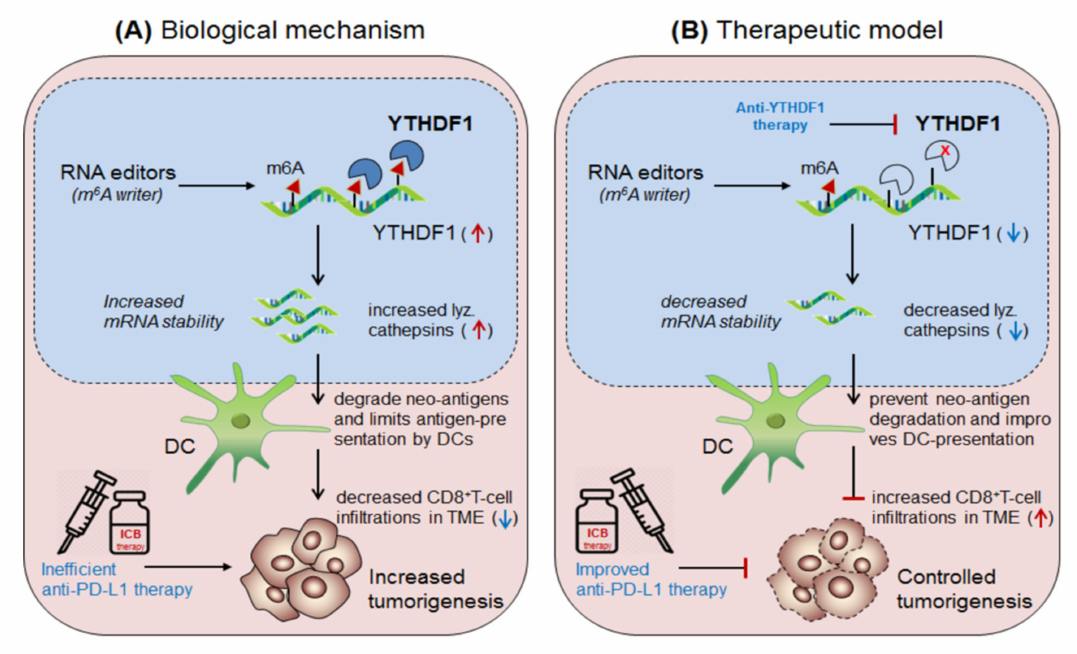
Figure 7. Therapeutic model targeting intracellular checkpoint ‘YTHDF1’ in enhancing DC-mediated anti-tumor immunity. ( A ) Biological mechanism: The ‘YTHDF1’ reader protein recognizes m6A-marked cathepsin transcript and increases it’s mRNA and protein level, which translocate into the phagosome and degrades neo-antigens, and thus limiting its recognition and cross-presentation by the DCs, and thereby the impaired DCs decreases CD8 + T-cell effector function, leading to decreased efficacy of anti-PD-1 therapy, resulting in increased tumor growth. ( B ) Therapeutic model: Anti-YTHDF1 therapy: inhibits cathepsin level and thus unable to degrade neo-antigens, resulting in effective antigen recognition and cross- presentation by DCs and thereby enhanced CD8 + T-cell effector function which improves the efficacy of anti-PD-1